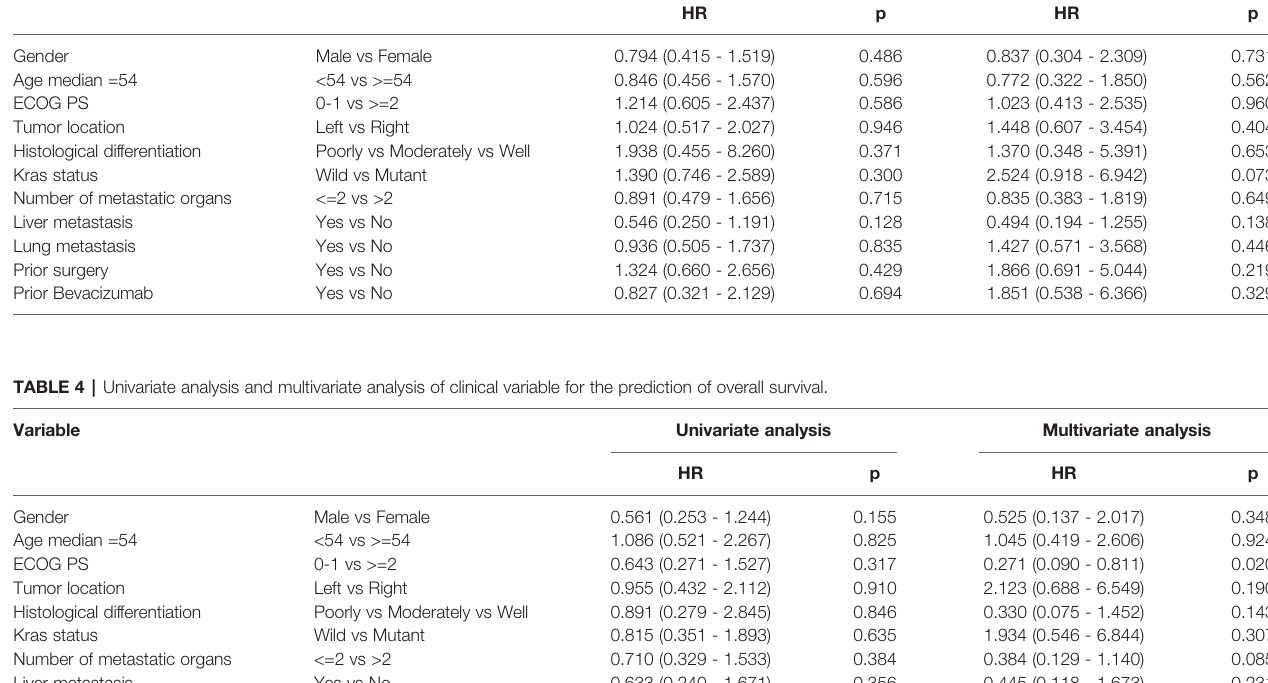
TABLE 3 | Univariate analysis and multivariate analysis of clinical variable for the prediction of progression free survival. Variable